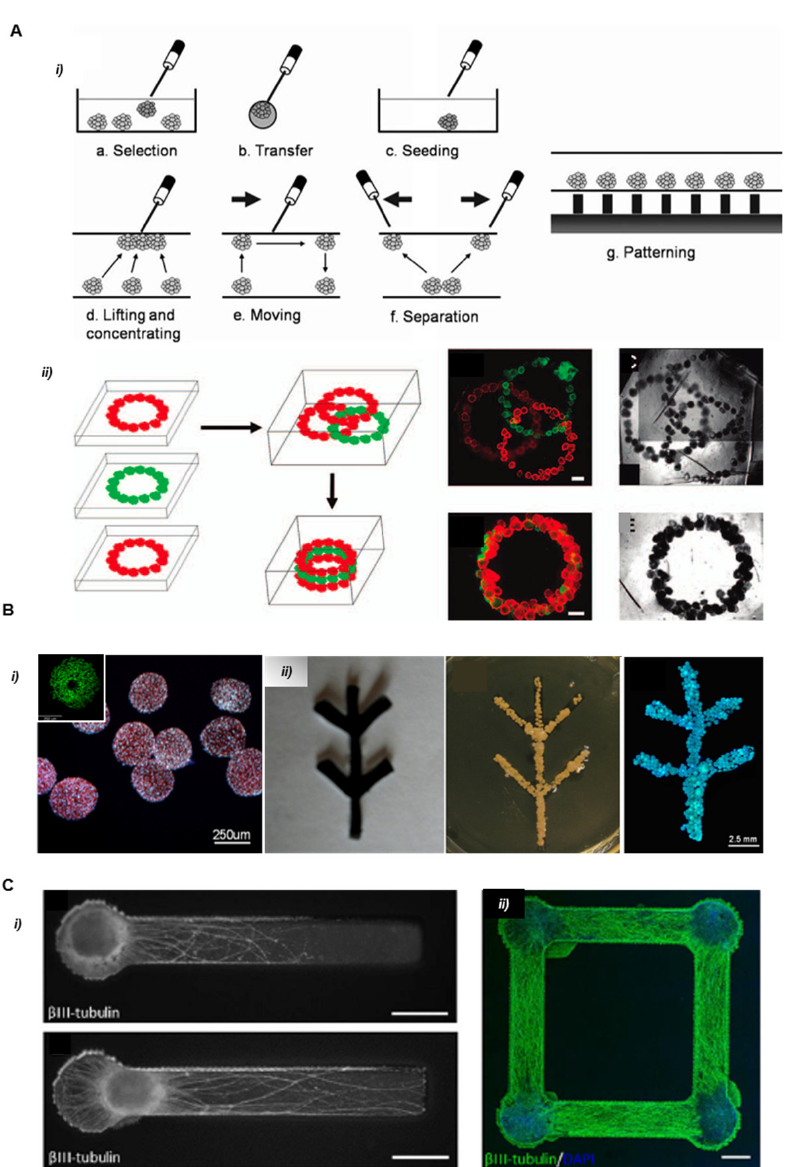
Figure 3. Manipulation of spheroids using a magnetic force. ( A ) (i) Schematic demonstration of spheroid manipulations that can be achieved by using a magnetic force. (ii) The scheme of layer-by-layer tissue reconstruction. Three pieces of human microvascular endothelial cell spheroids in Mebiol gel were stacked into an overlapped or aligned three-layered structure. Scale bars, 500 mm. Reprinted with permission from Ref. [29]. Copyright 2008, Mary Ann Liebert. ( B ) Patterning using paramagnetic particles (i) Size distribution and viability (inset) of superparamagnetic iron oxide nanoparticles (SPION) loaded endothelial cell spheroids. (ii) Light microscopy of magnetic template for the fusion of the spheroids (left panel). Magnetic assisted assembly of the spheroids at 48 h (middle panel). Confocal microscopy of preliminary fusion spheroids at Day 10 (right panel). Scale bar 2.5 mm. Reprinted with permission from Ref. [28]. Copyright 2013, John Wiley and Sons. ( C ) Magnetic assembly of central nervous system (CNS) spheroids. (i) Phase images of neural constructs ( β III-tubulin, white) indicate that the positioning of spheroids in constructs is more accurate with magnetic bioprinting (top panel) than manual placement with pipet alone (bottom panel). Scale bar 500 µ m. (ii) Confocal imaging showing localized cell bodies (blue) and extending neurites (green) demonstrating the accurate positioning of multiple spheroids in the same construct using a multi-magnet tool. Scale bar 200 µ m. Reprinted with permission from Ref. [30]. Copyright 2009, IOP